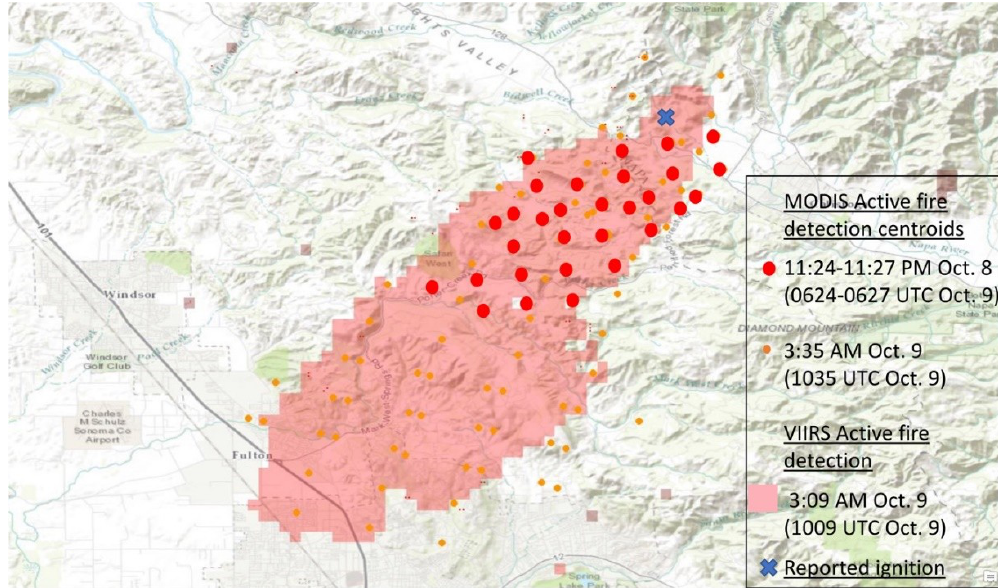
Figure 6. Satellite active fire detection data of the Tubbs Fire. The “X” indicates the reported ignition location. Active fire detection data is available at http://activefiremaps.fs.fed.us.